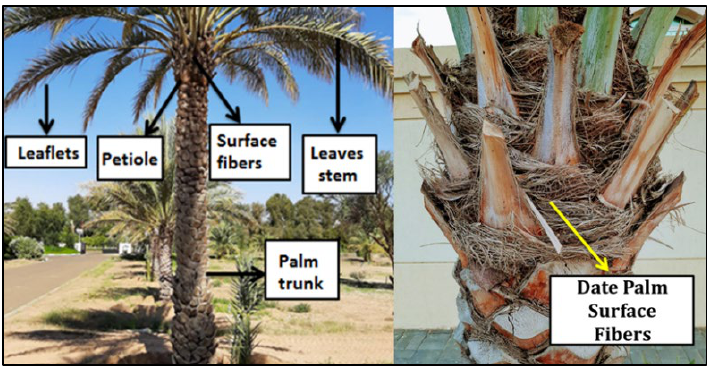
Figure 1. A date palm tree and its key material parts at the Al-Foah Experimental Farm of the UAE University, Al-Ain, United Arab Emirates.